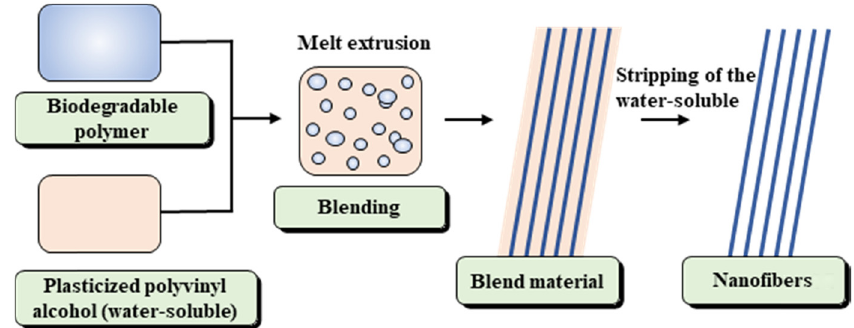
Figure 1: Schematic illustration of fabrication of biodegradable nano fi